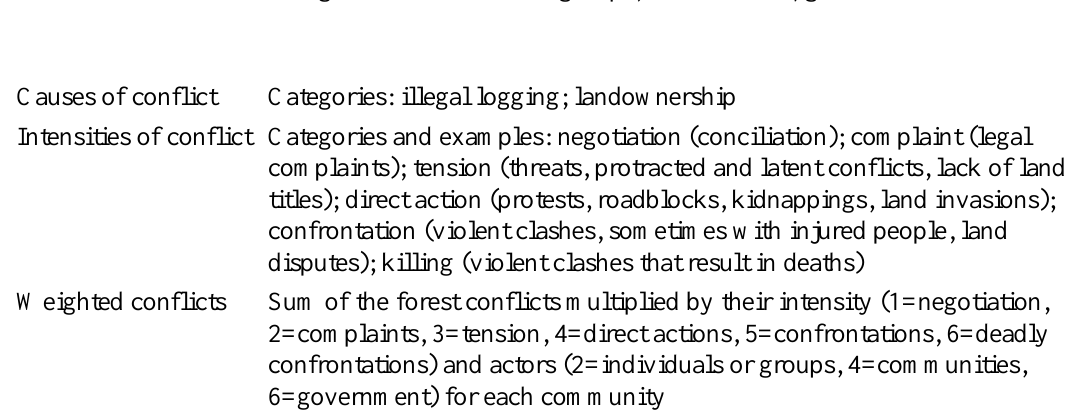
Table A1.1. Variables used for characterizing forest